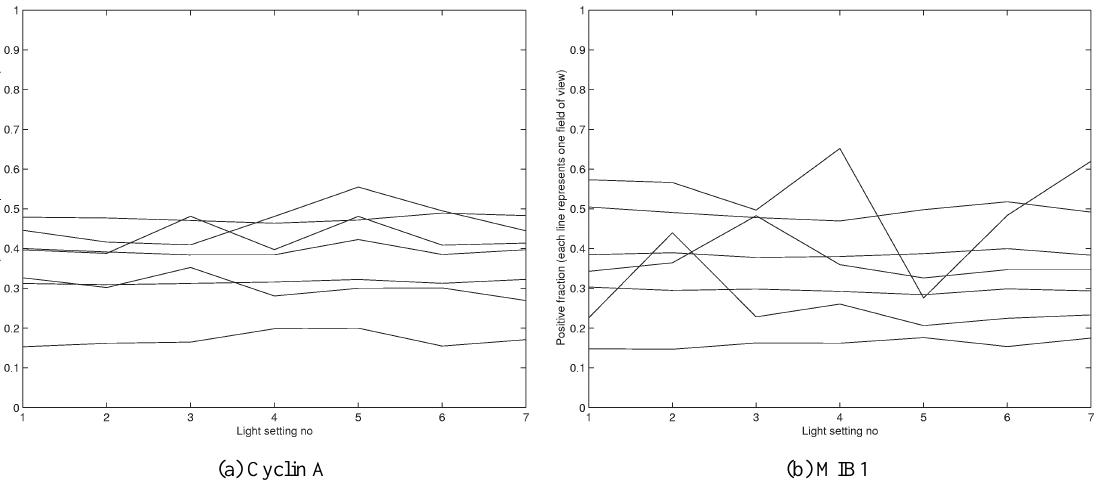
Fig. 11. Result when using automatic method without control cells (each line represents a field of view). In the ideal case there should only be straight